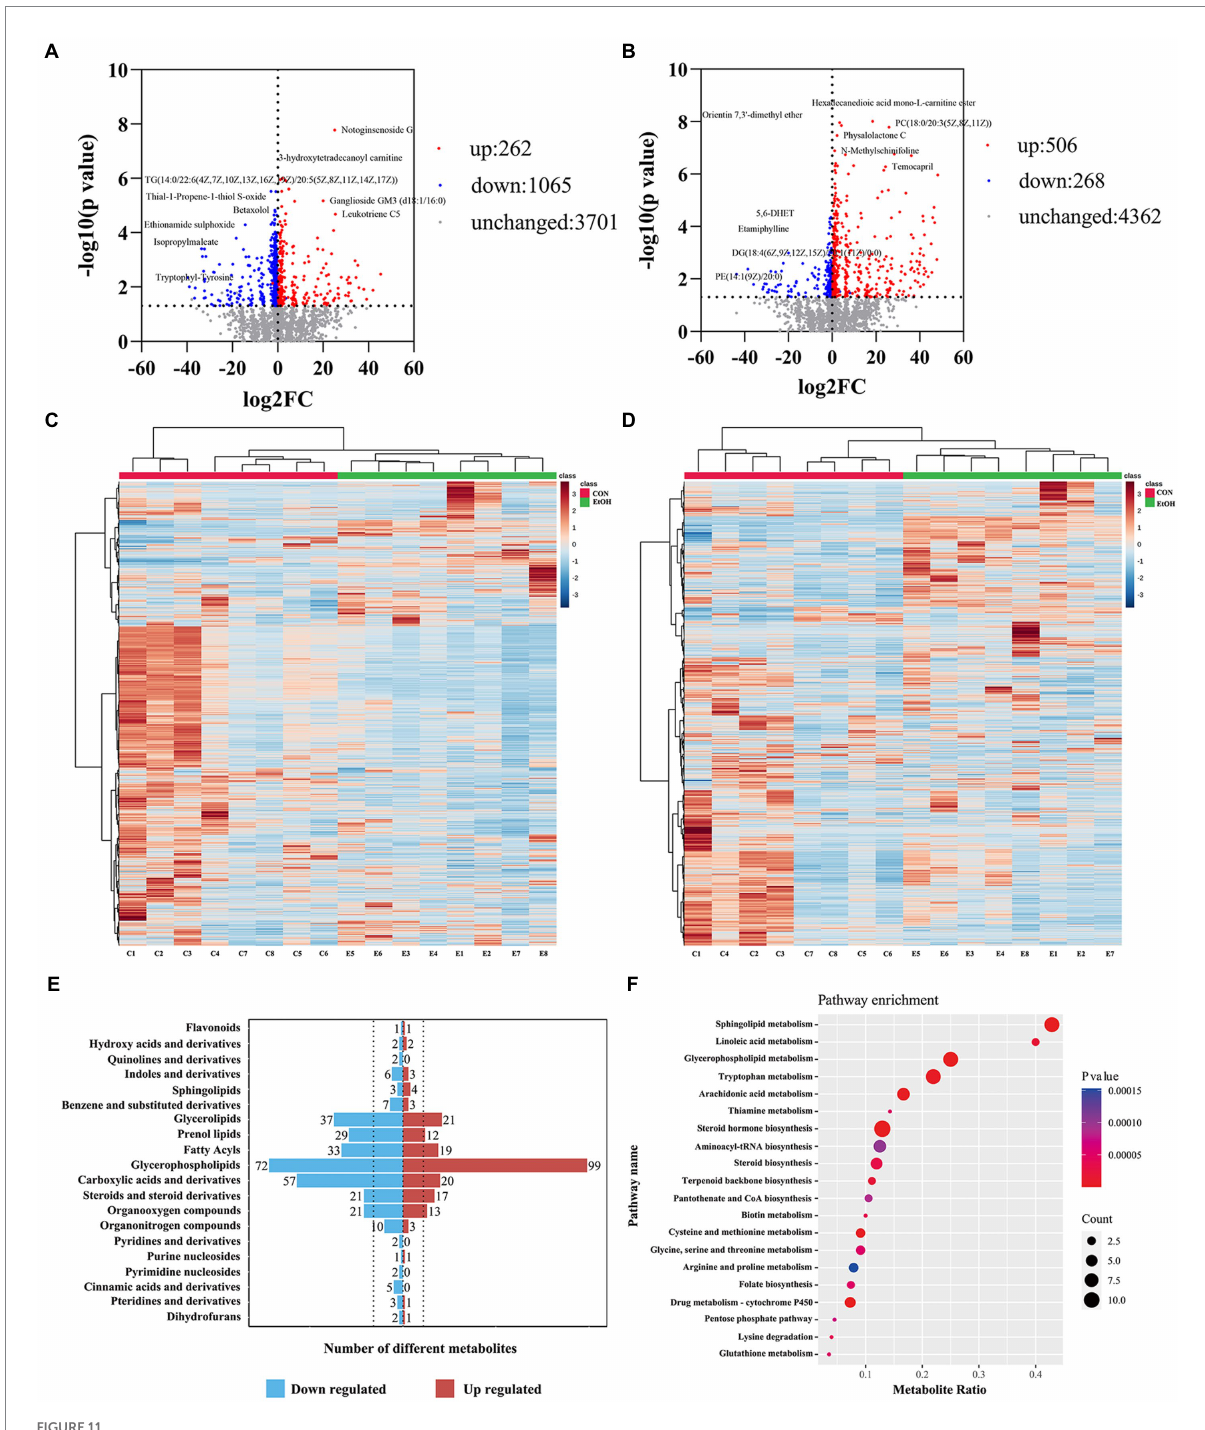
FIGURE 11 Differential metabolites in serum identification between EtOH and CON group at positive (A,C) and negative (B,D) ion mode. Expression of differential metabolites in the two groups was represented by Volcano plot (A,B) and heat maps (C,D) . The number of differential metabolites were annotated and classified based on the HMDB database (E) . The enrichment pathway of serum differential metabolites by Kyoto encyclopedia of genes and genomes (KEGG) analysis (F)